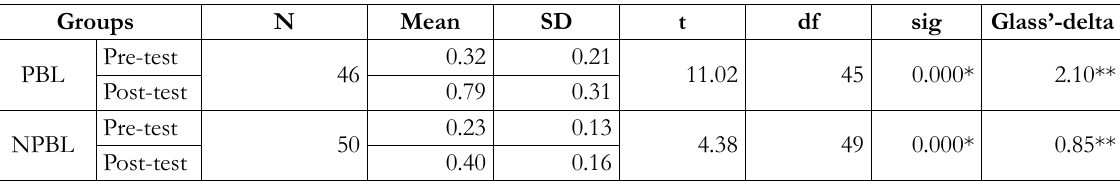
Table 11. Pre- and Post-test Mean Values Obtained from Problem Solving Skill Test, t-test Results and Effect Size Scores as “Glass’ – delta” from Each